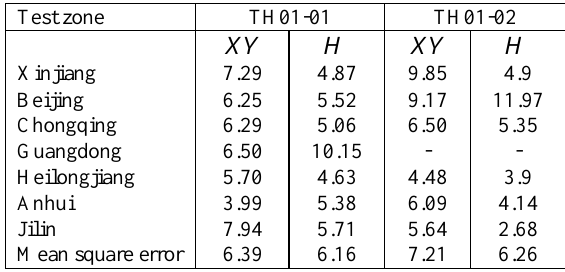
Table 4. Positioning accuracy of seven calibration fields after the calibration （ X , Y ： Gauss-Krueger Projection ， H